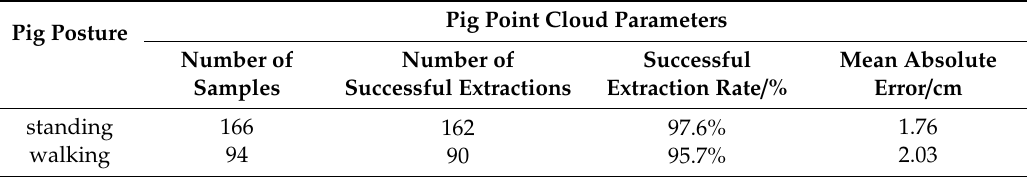
Table 2. Results of heart girth measurement point extraction for pigs in di ff erent